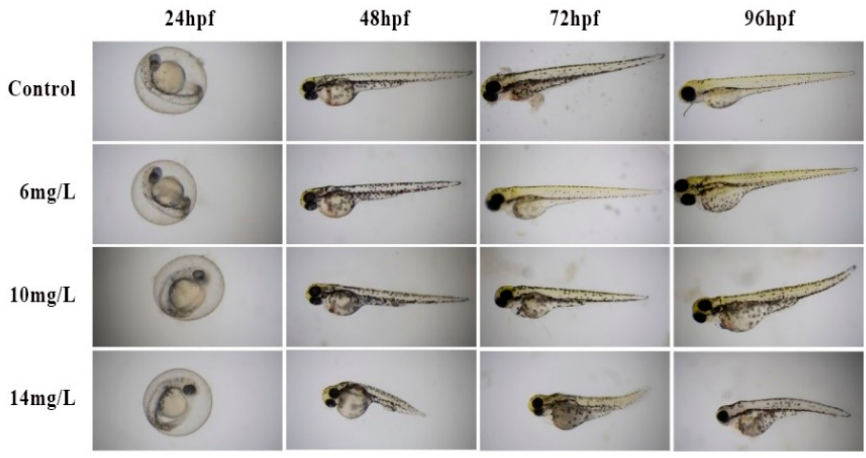
Figure 4. Zebrafish embryo malformation after exposure to compound 14h .